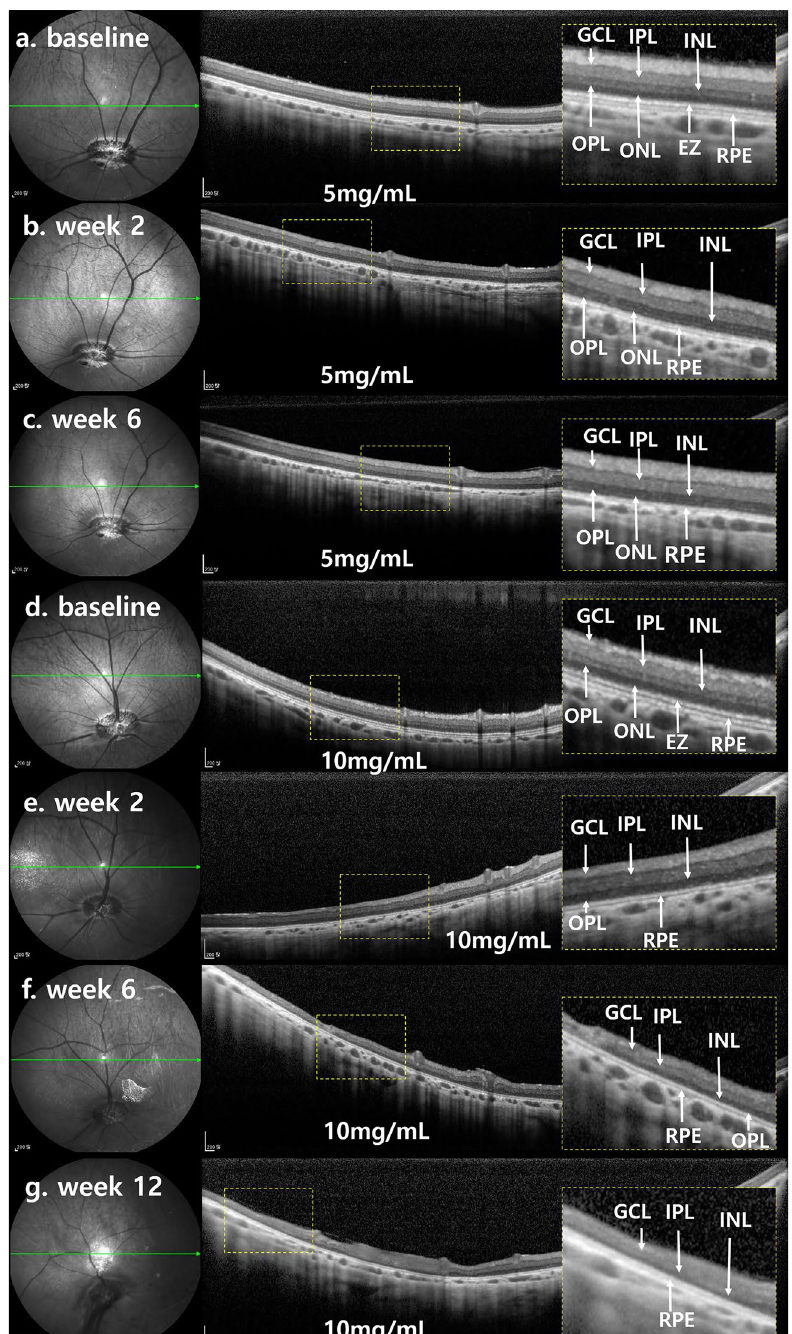
Figure 6. SD-OCT finding of each representative case of 5 mg/mL MNU and 10 mg/mL MNU. ( a–g ) Each magnified SD-OCT image of the case is from the right side and shown with a dashed-line box. ( a – c ). OCT images of a representative case with moderate outer degeneration in the 5 mg/mL group. ( a , b ) OCT images at week 2 showed intact GCL and RPE. The EZ was indistinguishable at week 2. In addition, there was a decrease in OPL thickness. ( c ) OCT images remained stable at week 6 compared with the results of week 2. ( d–g ) OCT images of a representative case with severe outer degeneration in 10 mg/mL group. ( d , e ) On the OCT, unlike baseline, the ellipsoid zone was indistinguishable at week 2. In addition, there was a decrease in INL thickness and ONL. ( f , g ) OCT image at weeks 6 and 12 showed no significant change compared with the results of week 2. However, the signal intensity of OCT decreased at week 12 due to anterior capsular opacity. SD‑OCT spectral domain optical coherence tomography, GCL ganglion cell layer, IPL inner plexiform layer, INL inner nuclear layer, OPL outer plexiform layer, ONL outer nuclear layer, EZ ellipsoid zone, RPE retinal pigment